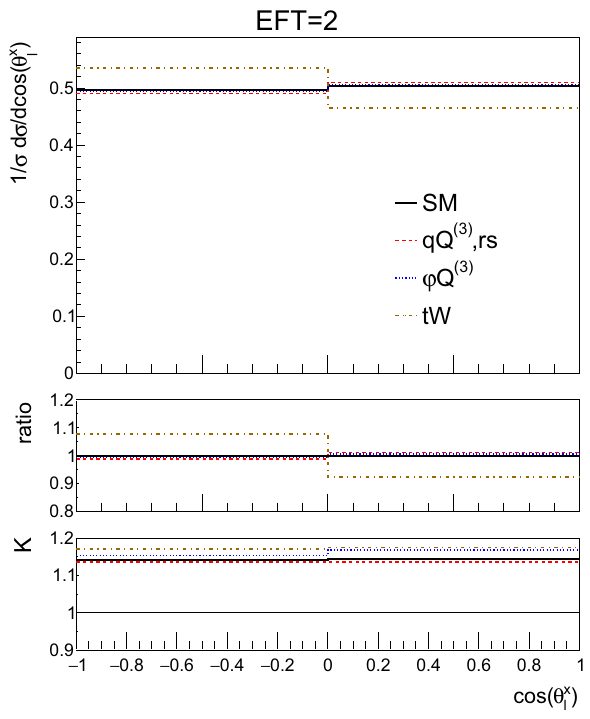
Fig. 15 The asymmetry between positive and negative values of the top polarisation angle (cos θ x ) by presenting Fig. 14 (left) in 2 l